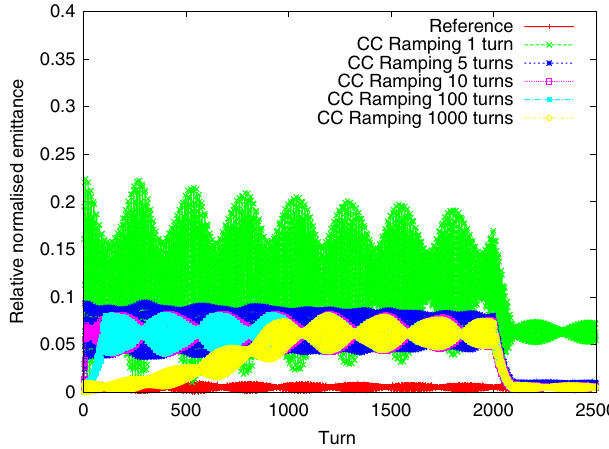
FIG. 18. (Color) Relative horizontal emittance growth for differ- ent ramping speed of one 800-MHz global crab cavity. A ramping period longer than 10 turns is required to avoid the emittance